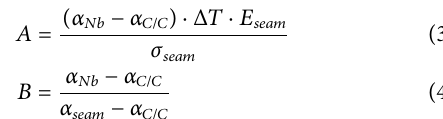
Frontiers in Materials |